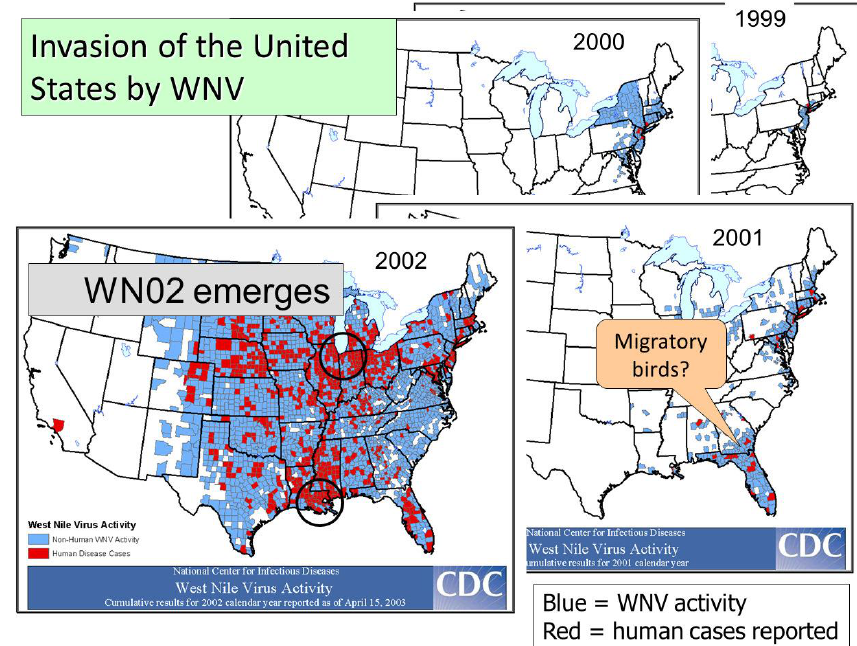
Figure 2. Sequence of maps showing the rapid expansion in the distribution of West Nile virus activity and human cases in the eastern United States from 1999 through 2002. Circles roughly circumscribe epicenters. [http://www.cdc.gov/ncidod/dvbid/westnile/